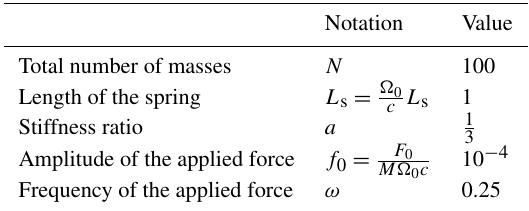
Table 1. Parameters of the discrete mass–spring chain.